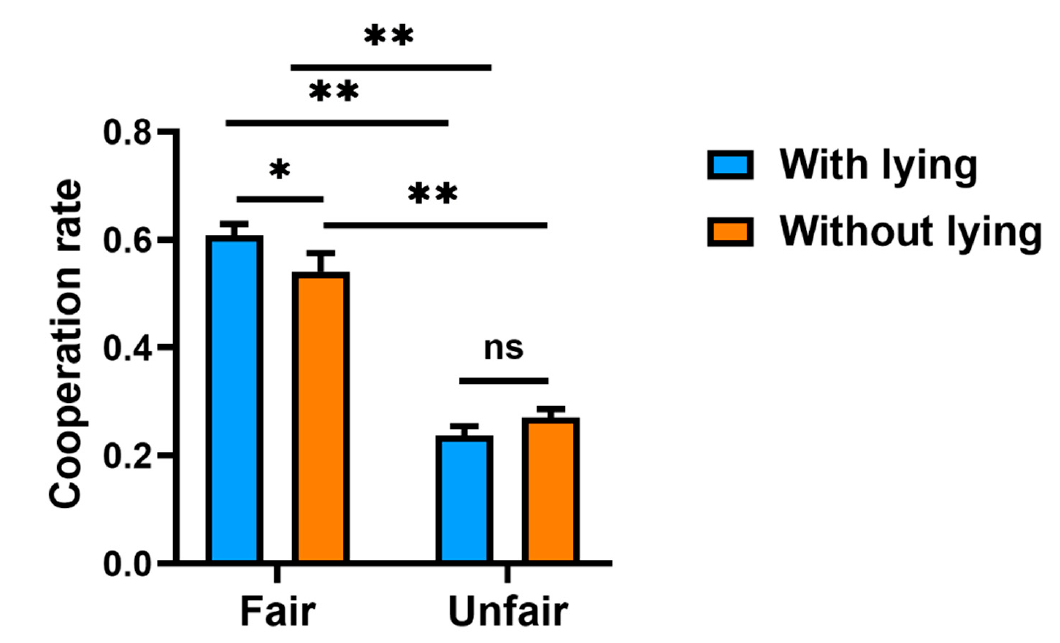
Figure 4. Results from the moderation analysis. The averaged cooperation rates were displayed as a function of lying (with vs. without), separately for the fair condition and the unfair condition. Error bars indicate standard error. *: p <0.05, ** p < 0.01, ns: no significant difference.